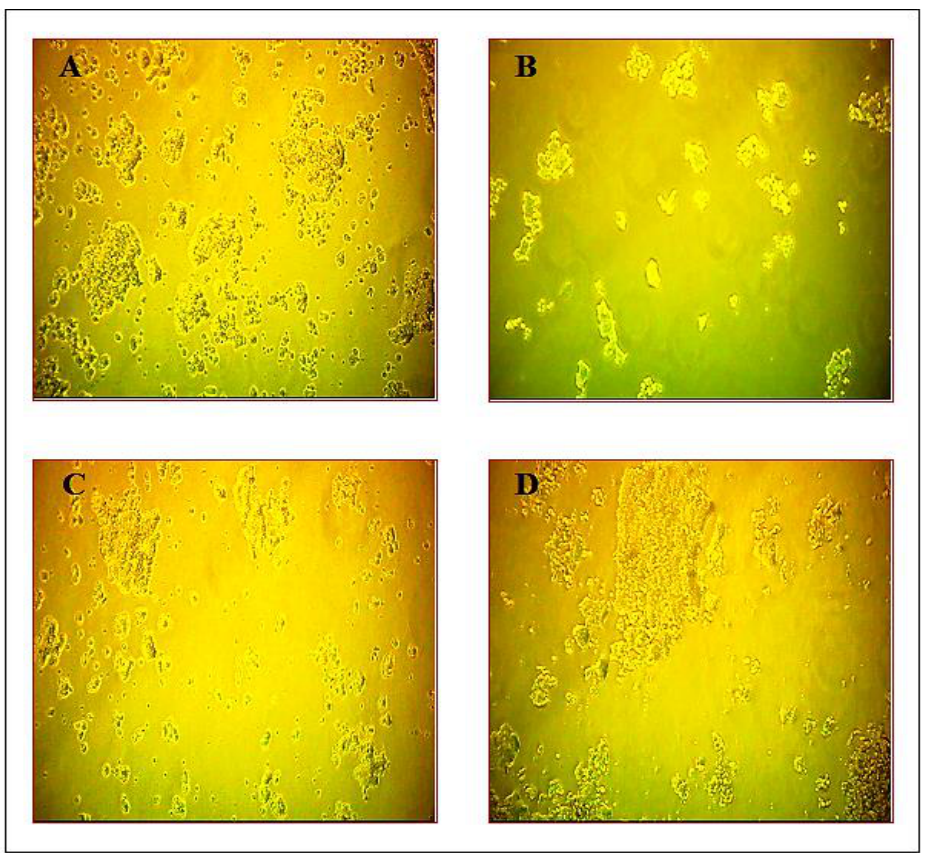
Figure 2. Effect of plant compound and clozapine on cell viability of PC 12 cell lines during in vitro ketamine treatment. ( A ) PC 12 cell line (control). ( B ) PC 12 cell line treated with ketamine for 12 h. ( C ) PC 12 cell line treated with clozapine for 2 h after ketamine treatment. ( D ) PC 12 cell line treated with plant compound for 2 h before ketamine treatment. Scale: 100 μ m.